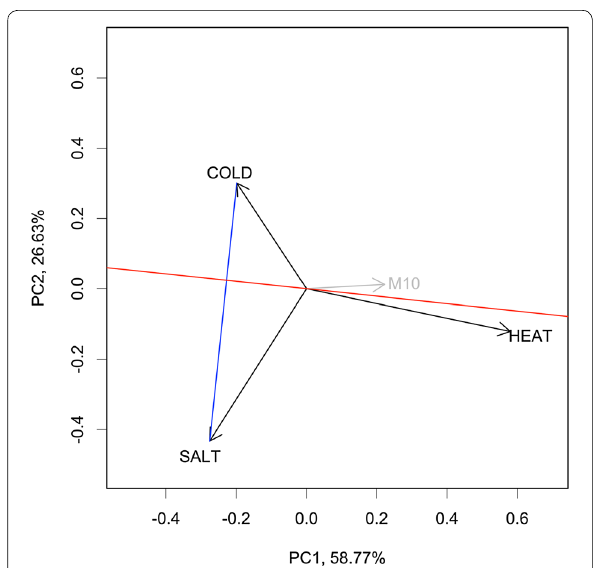
Fig. 1 An illustration of a biplot. The blue line represents the connec‑ tion between two stresses, and the red line passes through the origin and runs perpendicular to the blue line . The gray and black arrows are vectors of each gene module and stress,